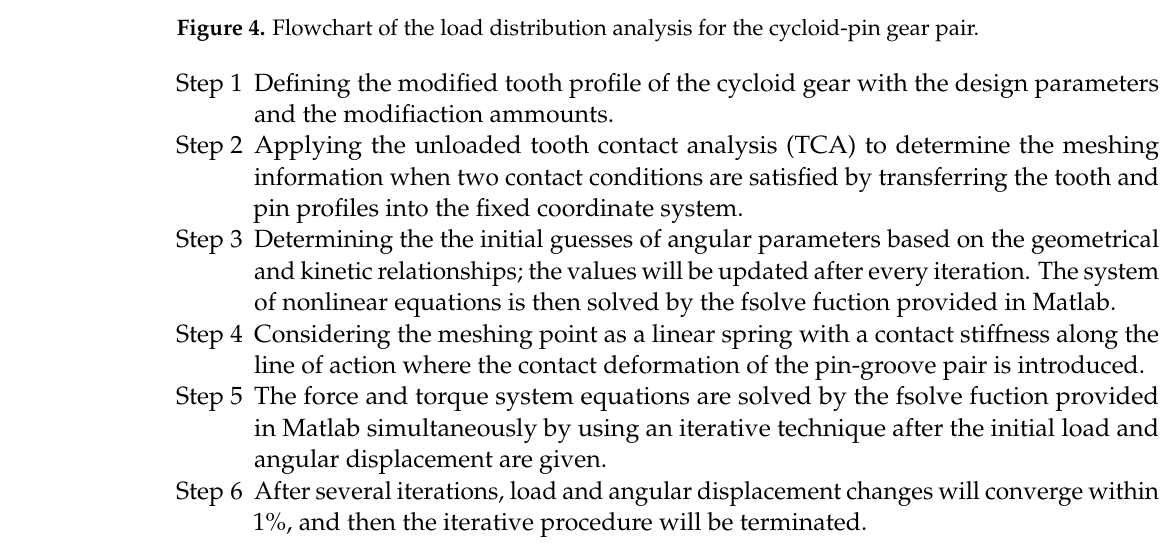
Figure 5. Coordinate systems for the unloaded TCA.